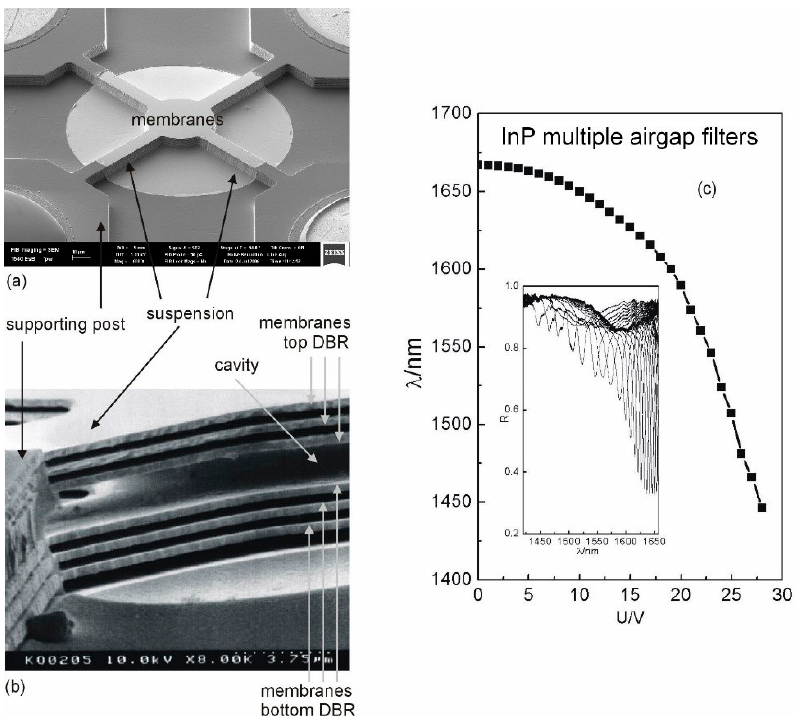
Figure 12. ( a ) SEM micrograph of an InP/InGaAs multiple airgap MEM tunable FP filter. ( b ) SEM micrograph from the side, allowing the view through the airgaps between the suspensions. ( c ) Wavelength of the filter peak wavelengths as a function of actuation voltage. The inset displays a selection of measured reflection spectra R ( λ ) recorded as a function of the actuation voltage U .